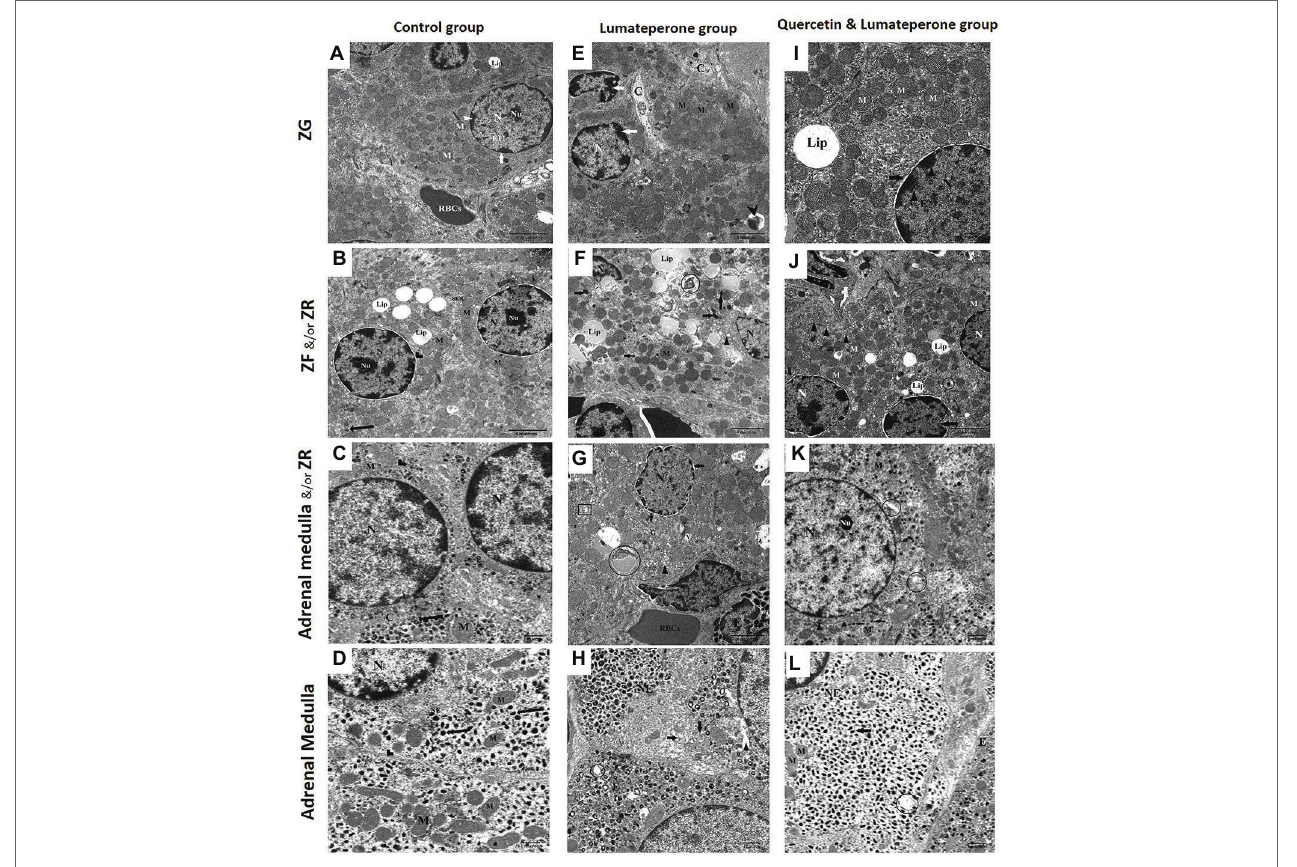
FIGURE 6 | Electron microscopy (A) Transmission electron micrograph of the adrenal gland in control group showing a more or less normal cell in ZG of suprarenal cortex with abundant lipid droplets (Lip), rounded nuclei surrounded by the nuclear envelope (arrow), having prominent nucleolus (Nu), heterochromatin (arrowhead) and euchromatin. Note: blood capillary contains RBCs, capillary typical ultrastructure with a normal endothelial wall (×8,000). (B) Control group showing most probably normal two adjacent cells in ZF and ZR of the suprarenal cortex. Cell in ZF demonstrating multiple lipid droplets (Lip), rounded nuclei surrounded by the nuclear envelope (arrowhead), nucleolus (Nu), and a lysosome (arrow). While ZR cells illustrating normal smooth endoplasmic reticulum (SER), mitochondria, round nucleus possessing peripheral heterochromatin and nucleolus (Nu; ×8,000). (C) Adrenal gland medulla of control group showing normal epinephrine with medium electron-dense granules (arrow), regular rounded nucleus, mitochondria, and intact cell junction (arrowhead), homogenous cytoplasm (×17,500). (D) Control group showing normal norepinephrine (NE) with very electron-dense granules (arrow) of the medulla, regular rounded nucleus, mitochondria, and intact cell junction (arrowhead; ×17,500). (E) Lumateperone-treated group showing ZG with severe infiltration with collagen fiber, lysosome (arrowhead) irregular nucleus with peripheral condensation of chromatin (arrow) and mitochondria (M; ×8,000). (F) Lumateperone-treated group showing ZF with massive accumulation and fusion of lipid droplet (Lip), distortion of lipofuscin drops (circle), pycnotic nucleus, increase in the number of lysosomes (arrow), dilated SER (arrowhead), and mitochondria (M; ×8,000). (G) Lumateperone-treated group showing eosinophilic infiltration of ZR, cells of ZR showing dilated SER (arrowhead), dilated perinuclear membrane (arrow), cytoplasmic vacuolations, irregular nucleus, degenerated mitochondria (rectangle), lipofuscin drops (circle) and congested blood capillary with RBCs. Note the normal appearance of Golgi (×8,000). (H) Adrenal gland medulla of lumateperone-treated group showing norepinephrine cell (NE) with a decrease in the number of secretory granules, partial lysis of cristae of mitochondria (arrow), rarified cytoplasm (arrowhead), also depletion of some secretory granules of epinephrine cell with degeneration of their mitochondria (curved arrow; (×17,500). (I) Quercetin and lumateperone-treated group showing more or less normal cells in ZG of suprarenal cortex with one large lipid droplet (Lip), rounded nuclei surrounded by the slightly dilated nuclear envelope (arrow), having heterochromatin (arrowhead) and euchromatin. Multiple normal mitochondria (M; ×8,000). (J) Quercetin and lumateperone-treated group showing the number of cells in ZF of suprarenal cortex with slightly irregular in the nucleus, mild indented nuclei of one of them (arrow), normal SER (arrowhead), different degree of saturation of lipid droplet (Lip), normal mitochondria and lysosome (circle; ×8,000). (K) Adrenal medulla of quercetin and lumateperone-treated group showing epinephrine with medium electron-dense granules (arrow), focal area of rarified cytoplasm (circle), regular rounded nucleus, nucleolus (Nu), normal mitochondria, and intact cell junction (arrowhead; ×17,500). (L) Transmission electron micrograph of the adrenal gland (medulla) in quercetin + lumateperone-treated group showing improvement in norepinephrine cell (NE) with electron-dense secretory granule (arrow), rounded regular nucleus, mitochondria, while epinephrine cell with medium electron-dense secretory granule (arrowhead). Note: few mitochondria in norepinephrine cells are degenerated (circle; ×17,500). N.B. Control with quercetin group showed the same findings as the control